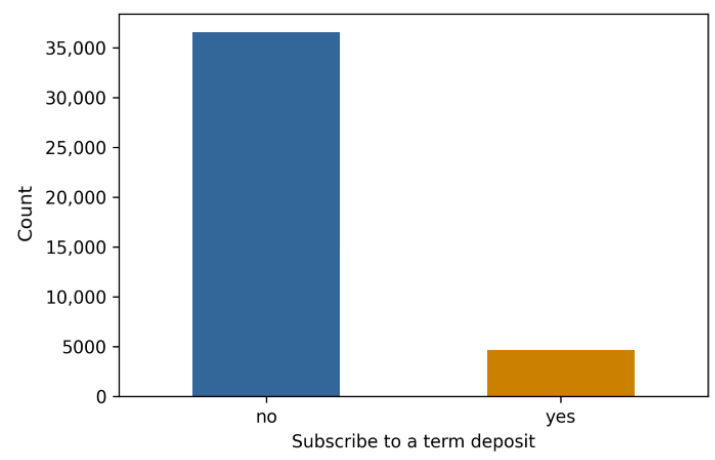
Figure 4. Distribution of dataset 2.